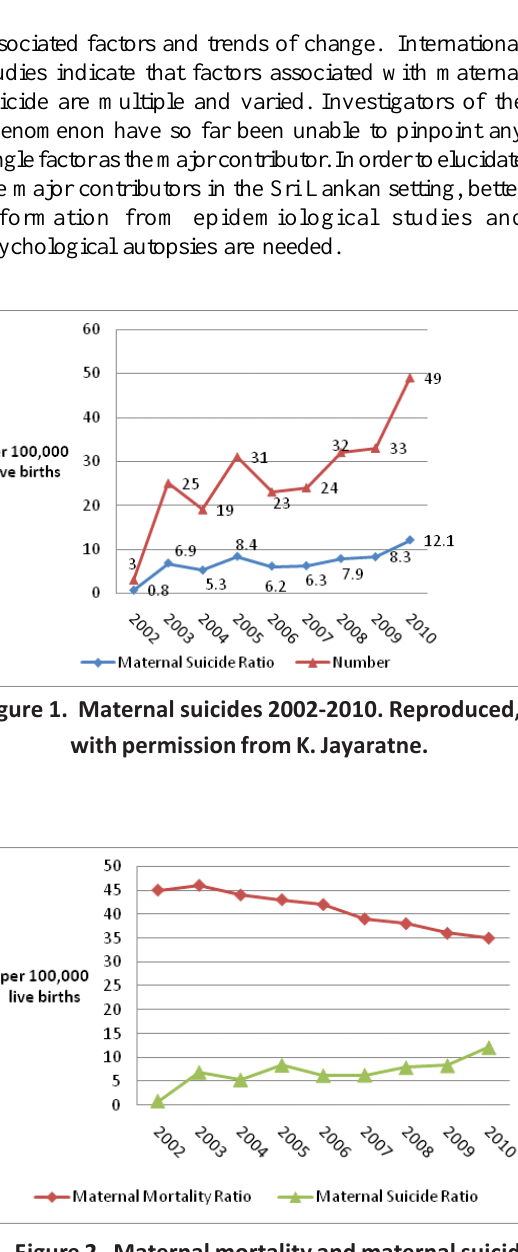
Figure 2. Maternal mortality and maternal suicide ratio